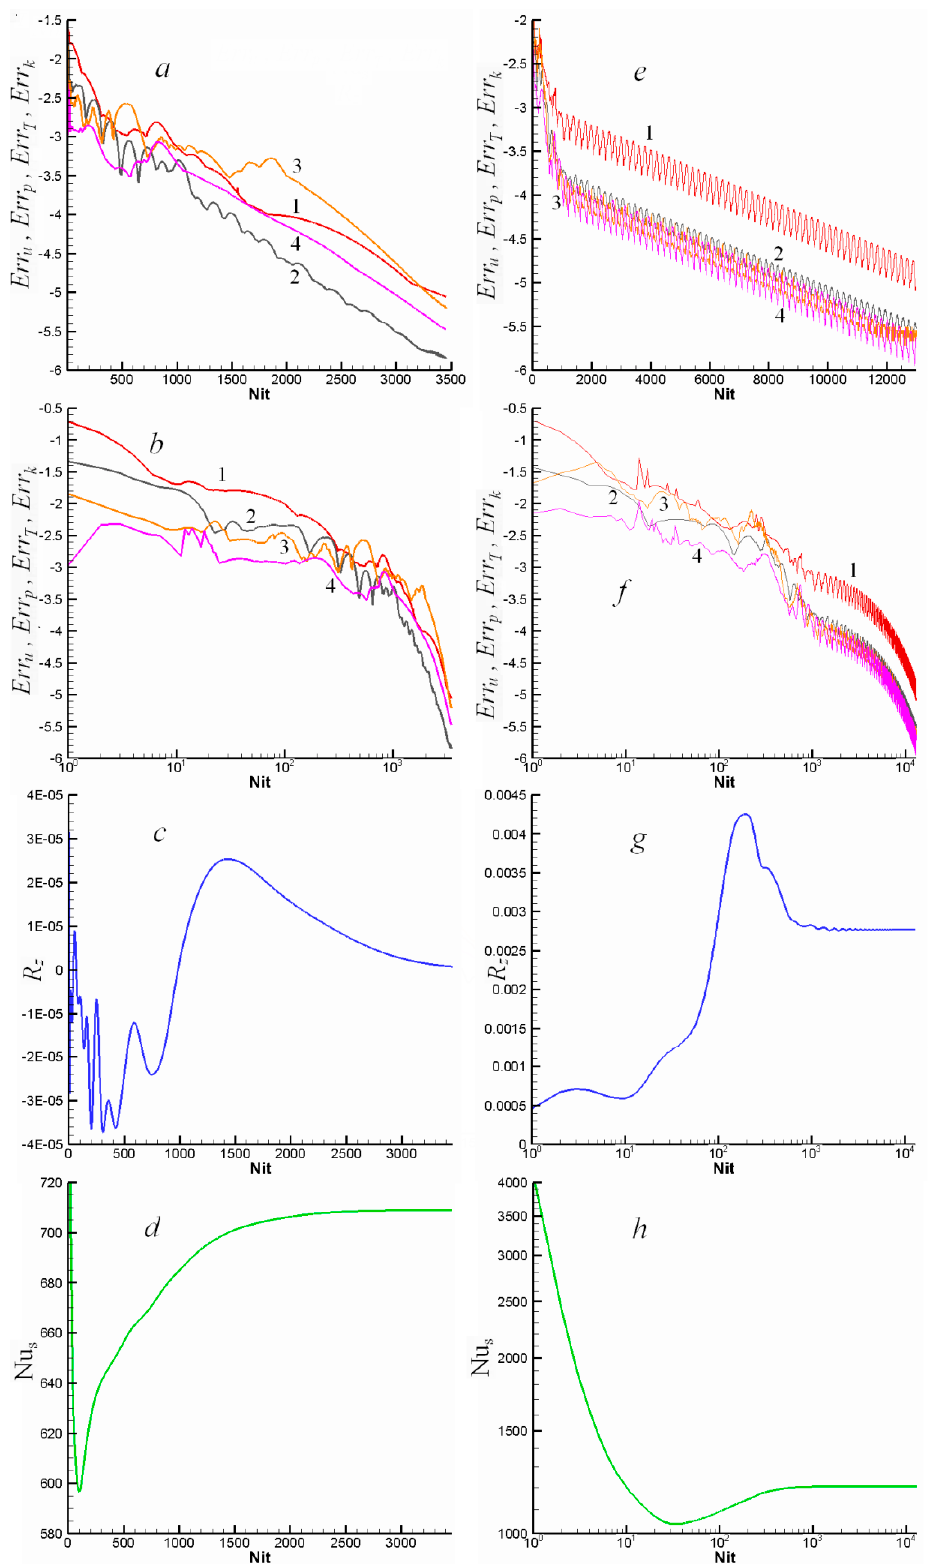
Figure 4. Convergence trajectories at linear ( a , e ) and logarithmic ( b , f ) scales, the dependences of the transverse load R z ( c , g ) and the Nusselt number Nu s ( d , h ) in the dimple region. Numbered curves: